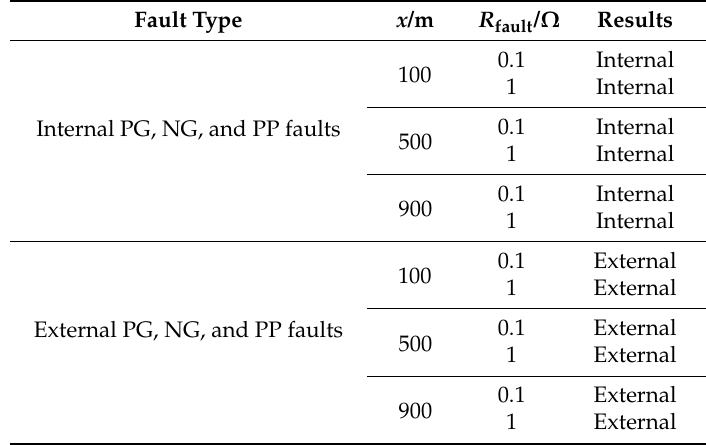
Table 2. Simulation results of internal fault